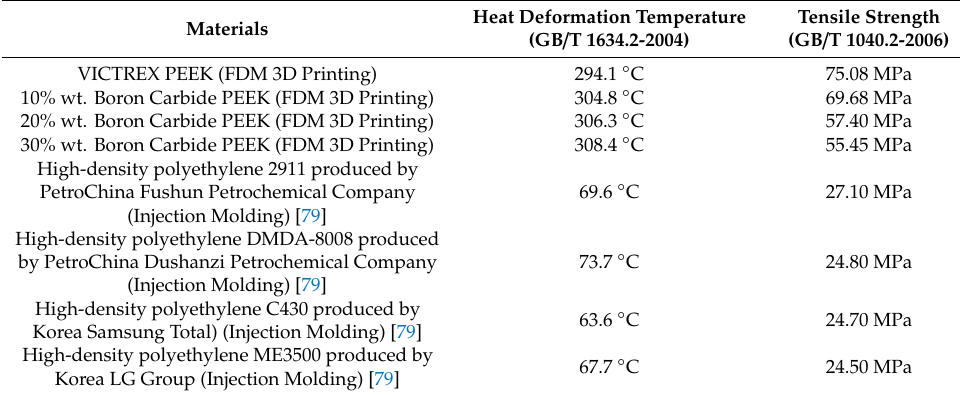
Table 4. Heat deformation temperature and tensile strength of PEEK / boron carbide PEEK composites /